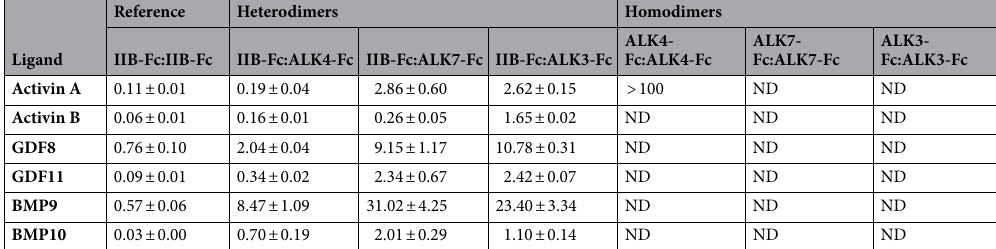
Table 2. Mean IC 50 values for ligand inhibition by Fc-fusion constructs in a reporter-gene assay. Values are means ± SEMs (n = 3), expressed in nM. ND, no inhibition determined at the highest experimental concentration for each molecule